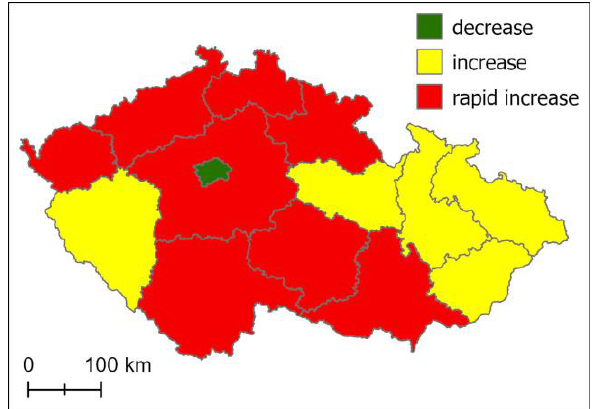
Figure 2. The trends in the number of forest fires in various regions of the Czech Republic.